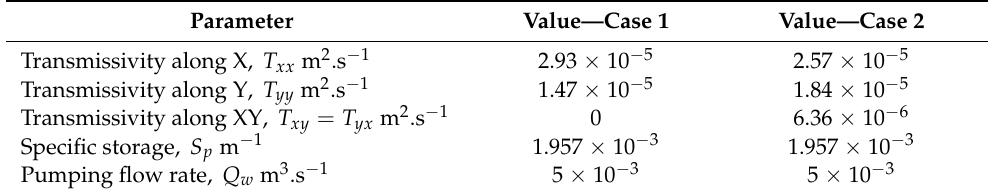
Table 1. Physical parameters used in the pumping test problem. Case 1 and 2 correspond to diagonal and fully symmetric transmissivity tensors, respectively.